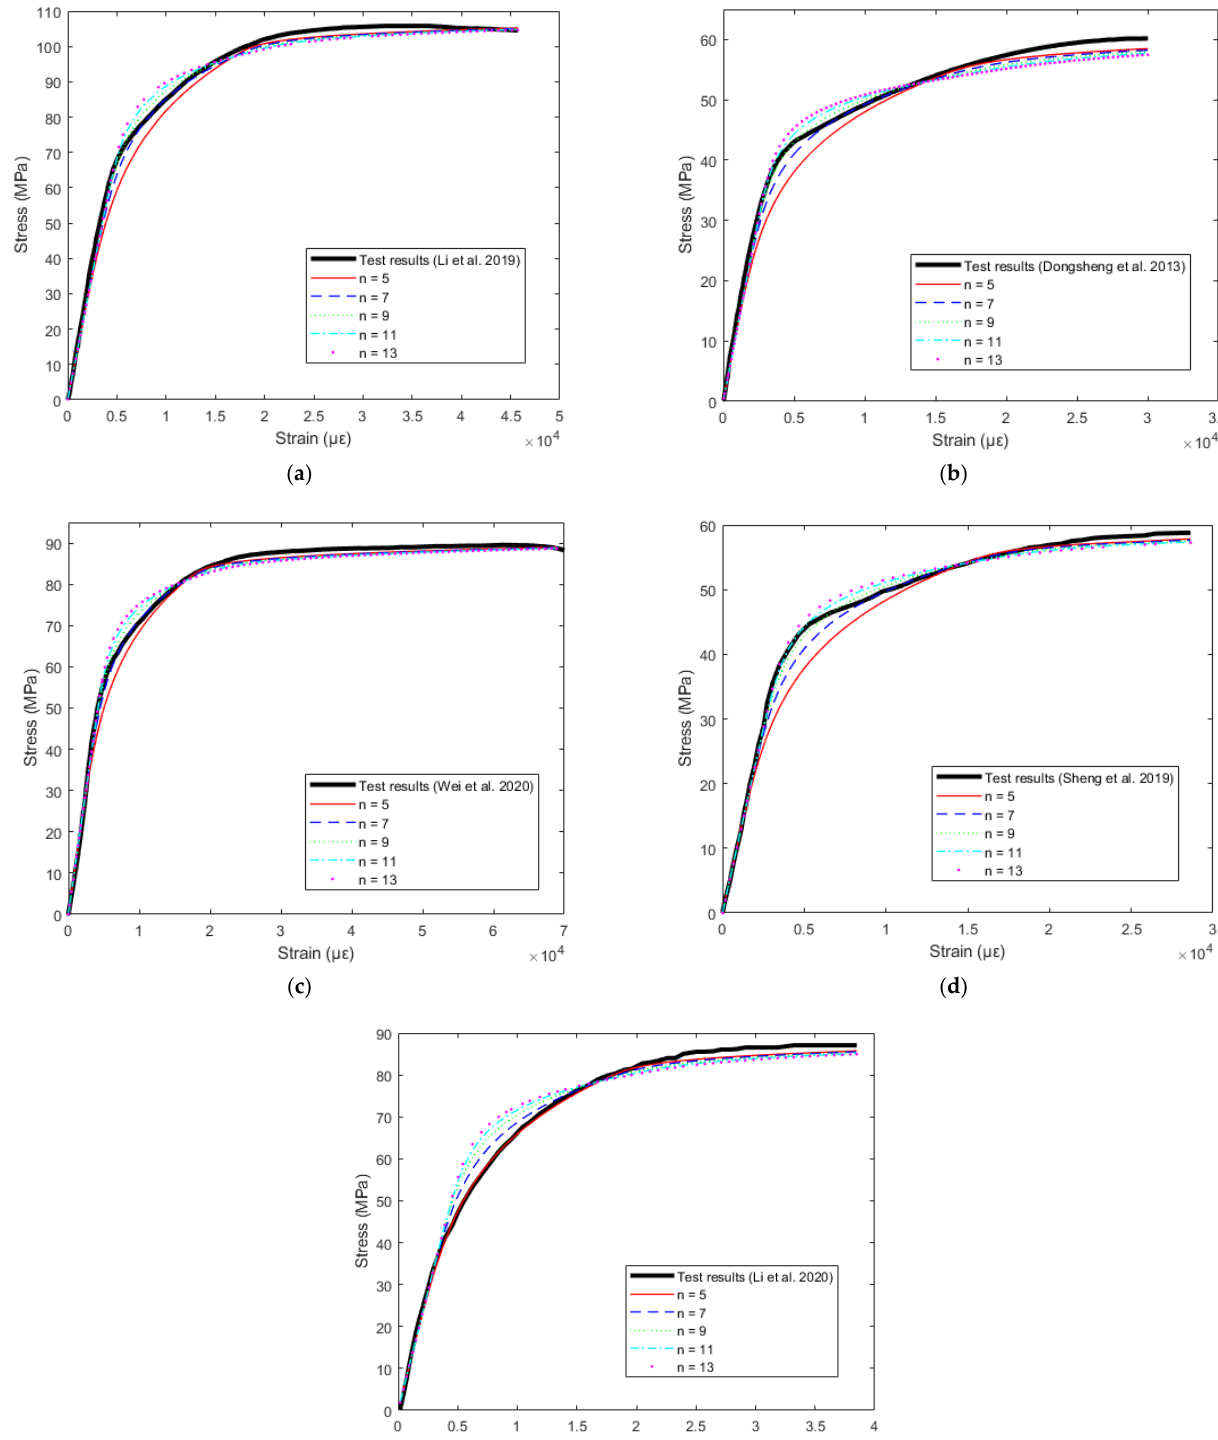
Figure 9. Sensitivity analysis of the shape parameter n for bamboo scrimber experimental studies: ( a ) Li et al., 2019 [19], ( b ) Dongsheng et al., 2013 [45], ( c ) Wei et al., 2020 [46], ( d ) Sheng et al., 2019 [47] and ( e ) Li et al., 2020 [48]. varying values of n and the lowest WLS values for each case is highlighted in bold. It is